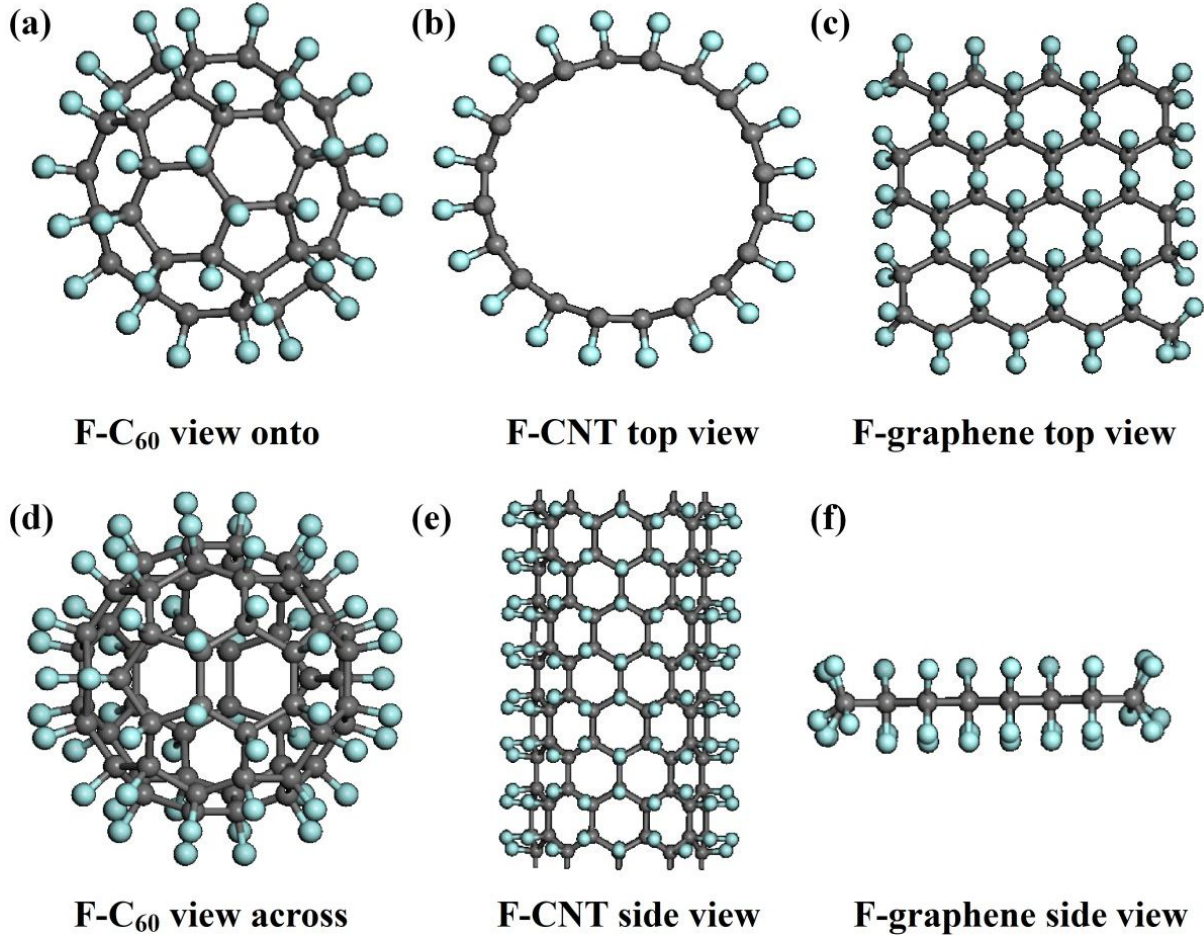
Figure 1: The schematic diagrams of some typical fluorinated carbons with an F/C ratio of 1:1. (a) F-C 60 view onto; (b) F-CNT; (c) F-graphene top view; (d) F-C 60 view across; (e) F-CNT; (f) F-graphene side